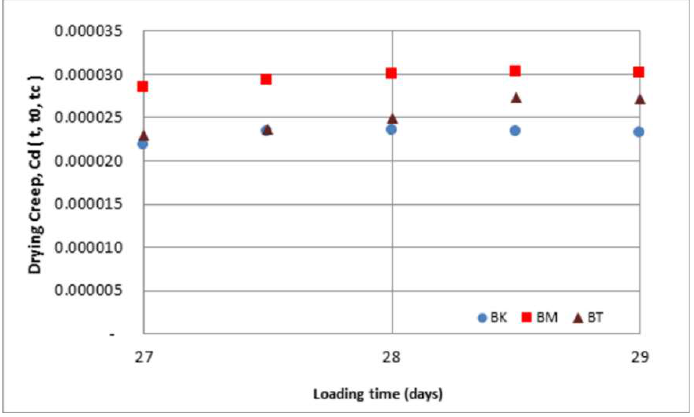
Figure 9. Compliance function J ( t , t 0 ) at 27–29 days of loading.